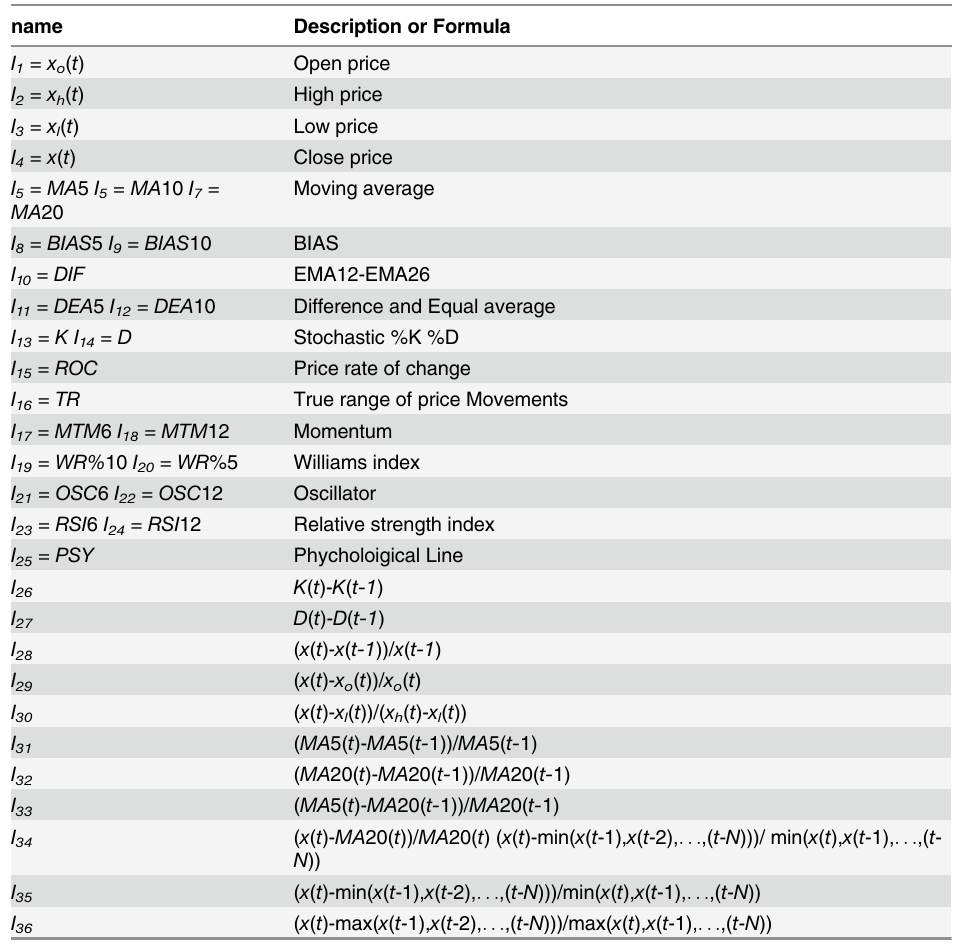
Table 1. Variables used as